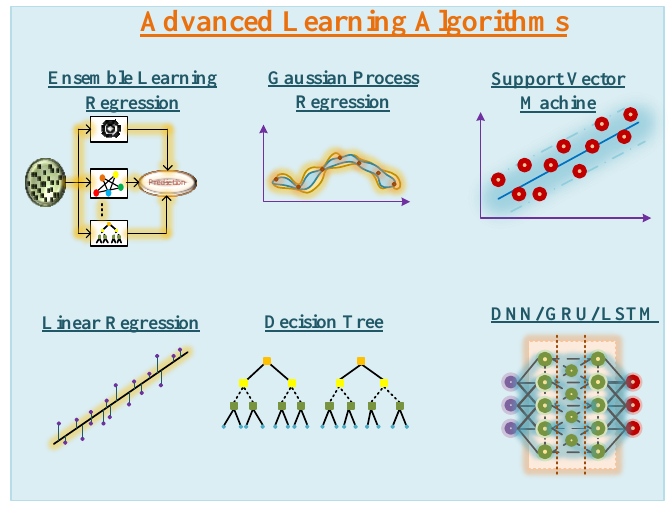
Figure 5. Principles of artificial intelligence models.